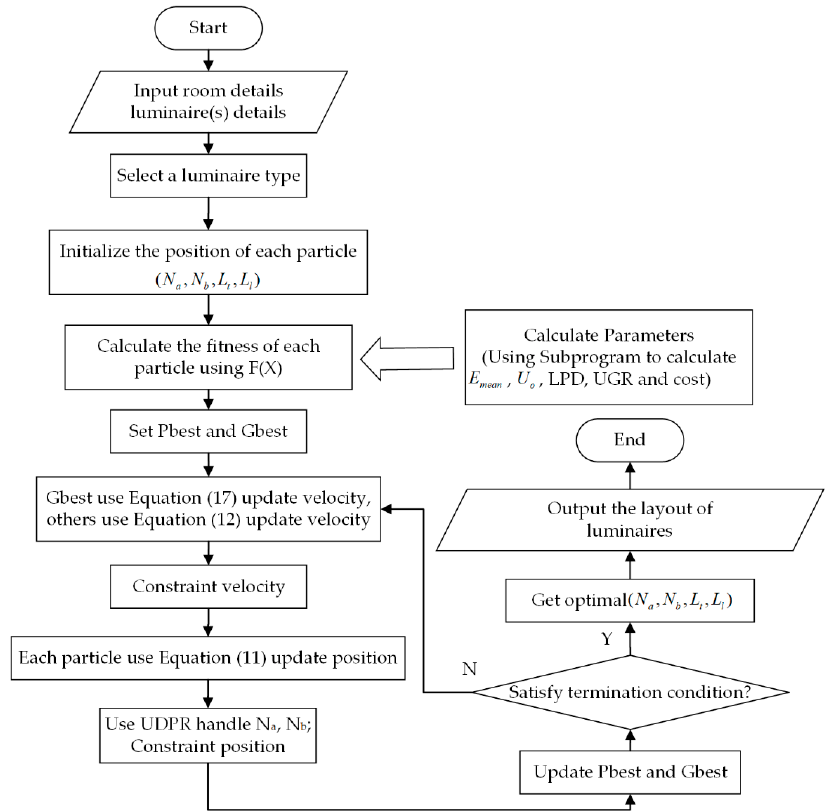
Figure 5. The flow diagram of the optimization process with an IPSO-based method.